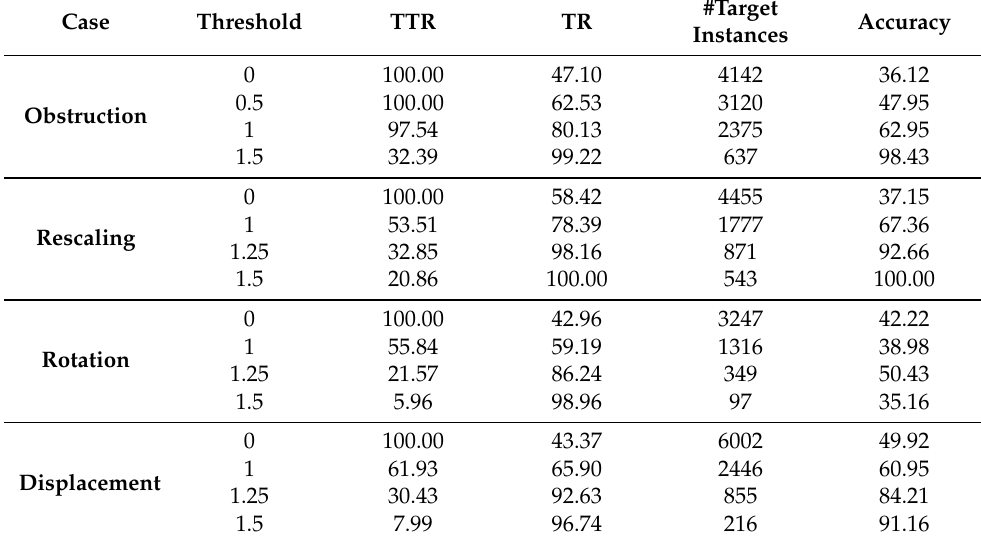
Table 3. TTR denotes the percentage of total transfer-relevant instances captured by the threshold. TR denotes the percentage of TRIs in the dataset after the threshold is applied.